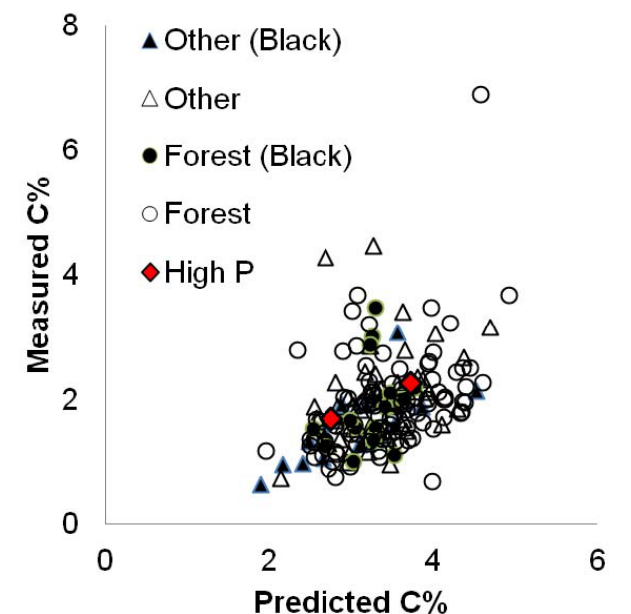
Figure 1. Predicted versus measured percent carbon in the soil profile (0–20 cm depth) using the function developed in relatively similar conditions in Sumatra [17] based on soil texture and other factors applied to 183 well drained sites assessed in Malinau, Kalimantan (first survey). Symbols distinguish natural old-growth forest from other (human modified) sites, and those with black ( i.e. , dark soils) from the rest. The two sites with notably high P are individually